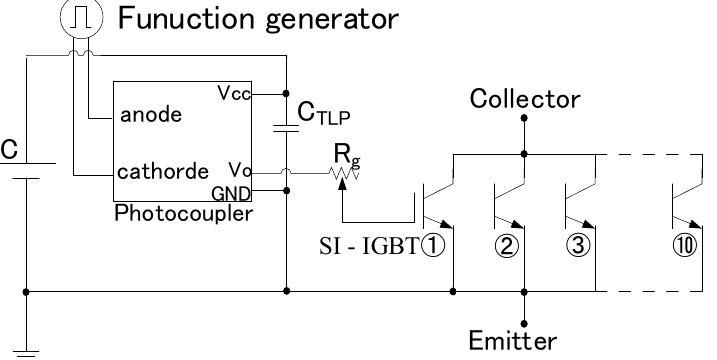
Figure 2. Si ‐ IGBTs gate circuit diagram. A photocoupler was used to insulate the primary side from the secondary side. The gate signal output from the photocoupler was input to 10 IGBTs connected in parallel. The main current did not flow through the semiconductor in the current experiment considering that SI was unsaturated.